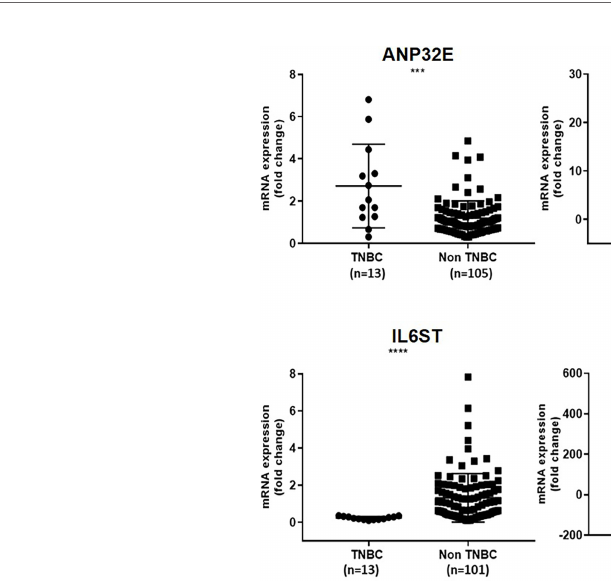
TABLE 3 | Association of ANP32E, DSC2 and IL6ST mRNA expression with clinicopathological features in TNBC cases from the fi rst cohort. Characteristic ANP32E DSC2 IL6ST Total High Low P- value